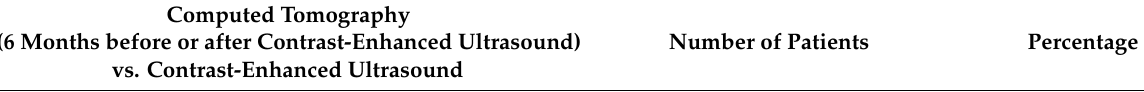
Table 5. Depiction of the different findings during computed tomography and contrast-enhanced ultrasound.